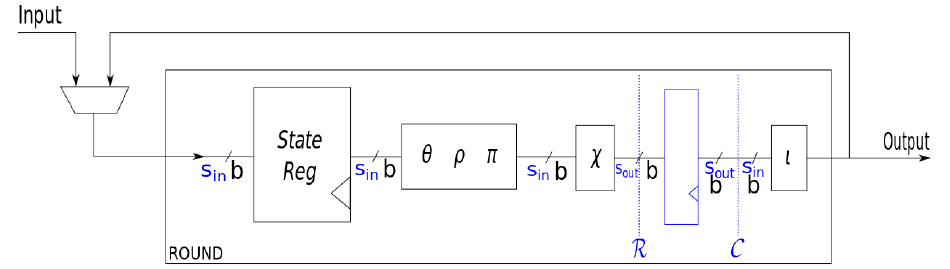
Figure 1: Datapath of protected (blue) and unprotected round-based Keccak implementa- tion with and without χ -compression